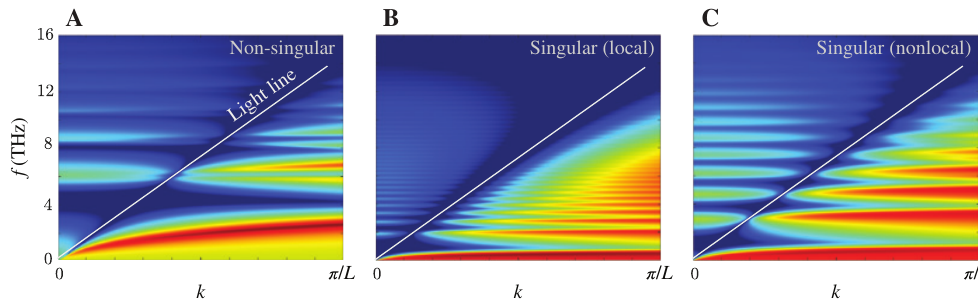
Figure 4: (Left-to-right) Plasmonic band structures for non-singular, singular (local) and singular (nonlocal) graphene metasurfaces. Plasmonic band structure of the non-singular ( Δ = 1) (A) and singular ( Δ = 3) (B, C) metasurfaces, visualized by plotting the logarithm of the absolute value of the reflection coefficient. Note that to the right of the light line, the incoming waves are evanescent. Local (A, B) and nonlocal (C) spectra differ significantly for the singular case Δ = 3 only. (A) In the non-singular regime, band gaps are clearly visible at the edge of the Brillouin zone, with the respective upper bands showing significantly larger broadening compared to the lower ones. (B) In the singular limit, local calculations predict that the band above of each band gap becomes indistinguishable from the lower band of the gap above, effectively realizing a series of flat bands, with extremely low group velocities. However, the onset of Landau damping in the nonlocal case (C) greatly broadens these bands, in addition to saturating their compression as in Figure 3. In addition, note that the bands are effectively degenerate at k = 0, due to the inversion symmetry of the